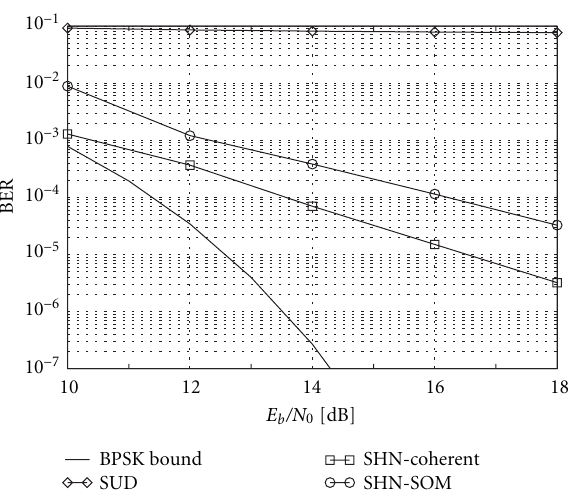
Figure 12: The OPOBS channel with Walsh-Hadamard codes.